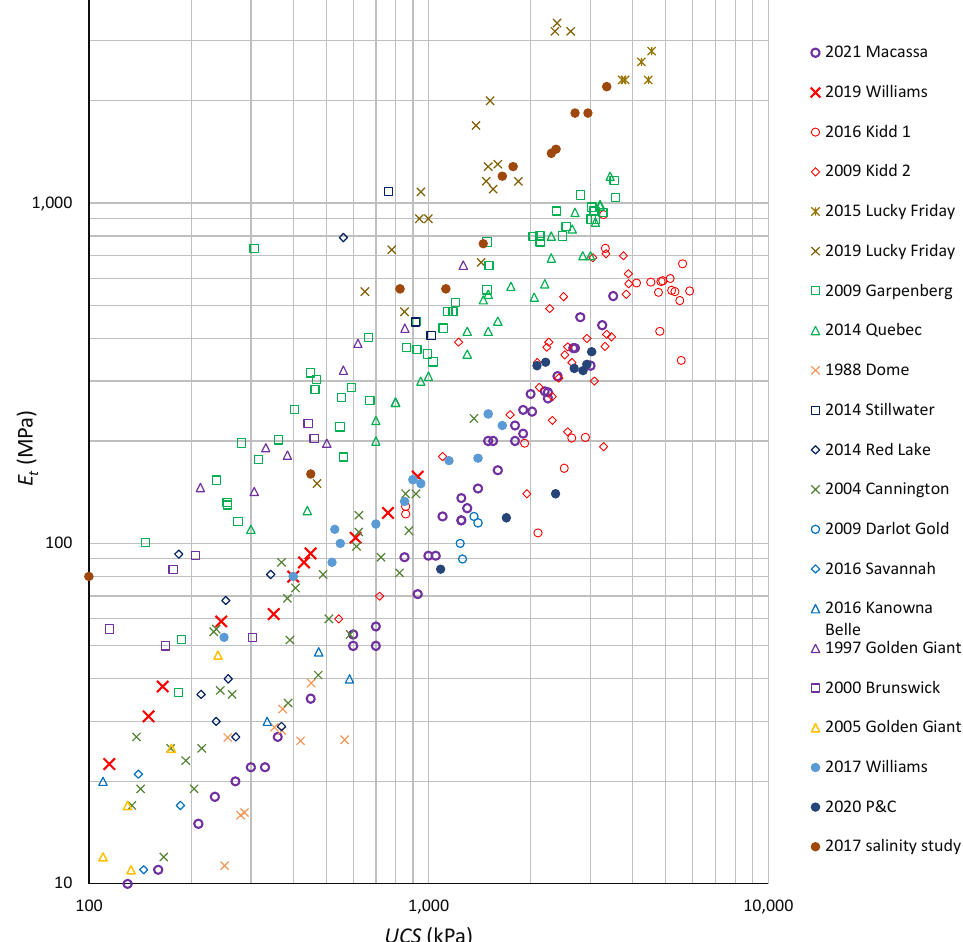
Figure 10. Relationship between E t and UCS : combined results (the salinity study markers may be an order of magnitude too high, see footnote of Table 2).